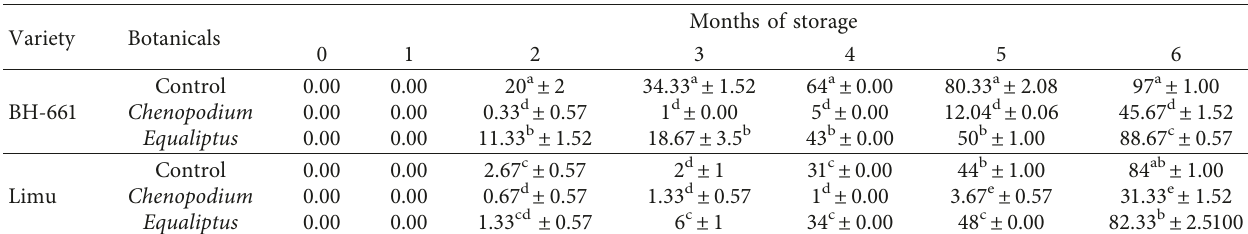
Table 3: Effect of botanicals and variety on percent insect damage (mean ± SD) of maize.